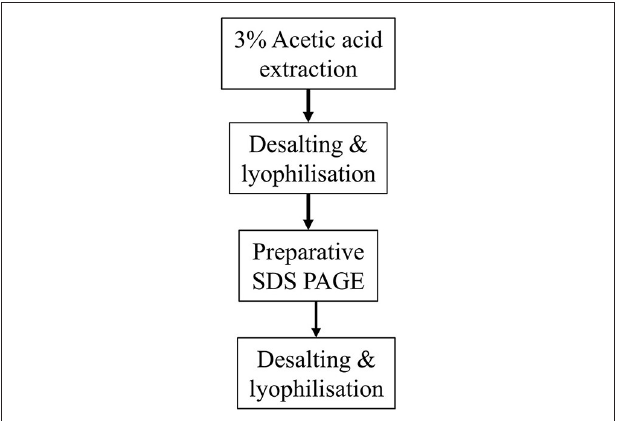
FIGURE 8 | Proposed methodology using preparative SDS PAGE purification of His-tag free recombinant